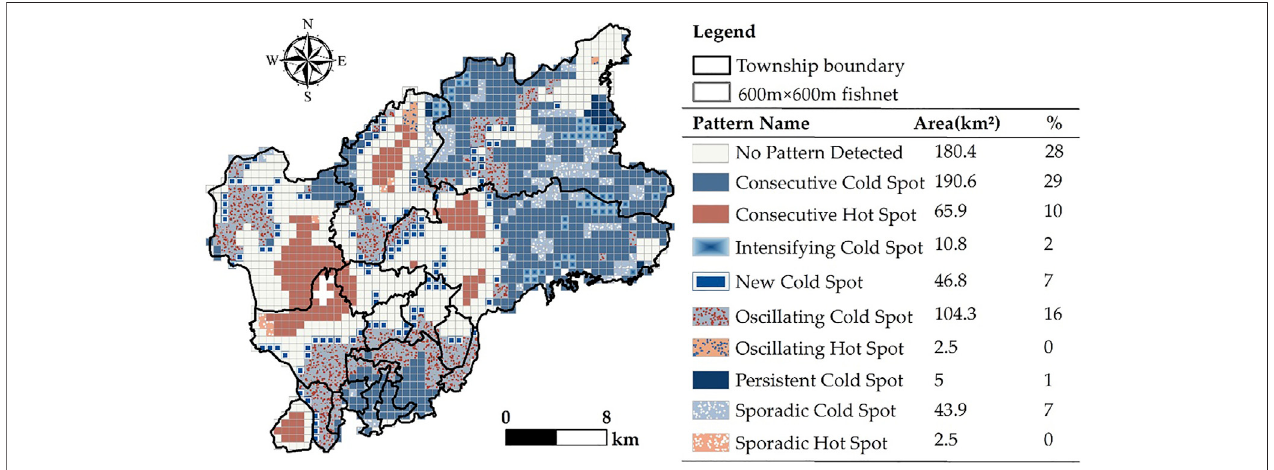
FIGURE 6 | Distribution of spatiotemporal cold and hot spot trend and the quantity of each pattern in Baiyun District, 1980-2020.